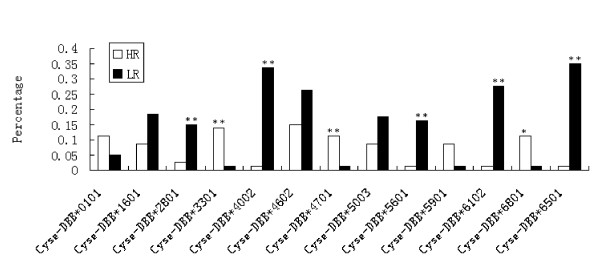
Sequence polymorphism analysis within exon 2 of MHCIIB gene. (Asterisks indicate the correlative amino acid that combines the antigen).